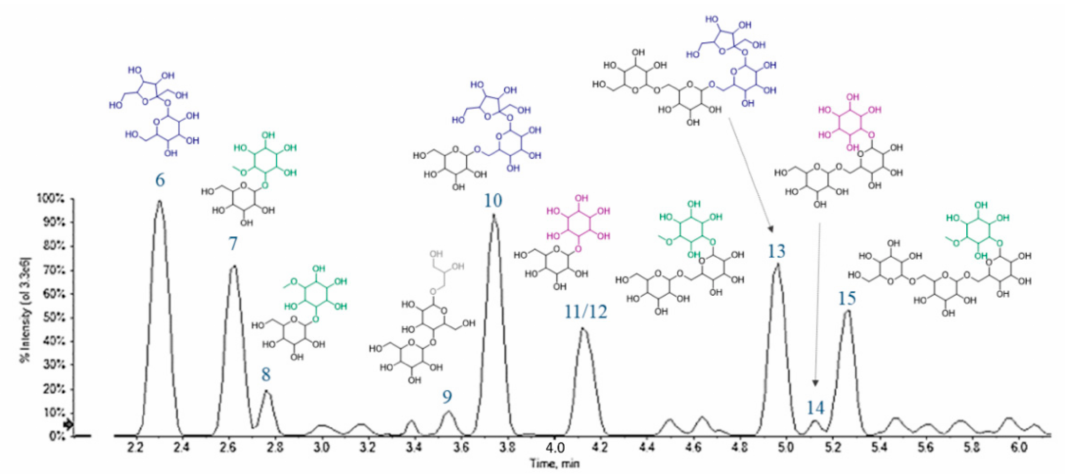
Figure 8. A representative chromatogram of Cf-W fraction, in which the tentatively assigned chemical structures of sugar derivatives are assigned to each